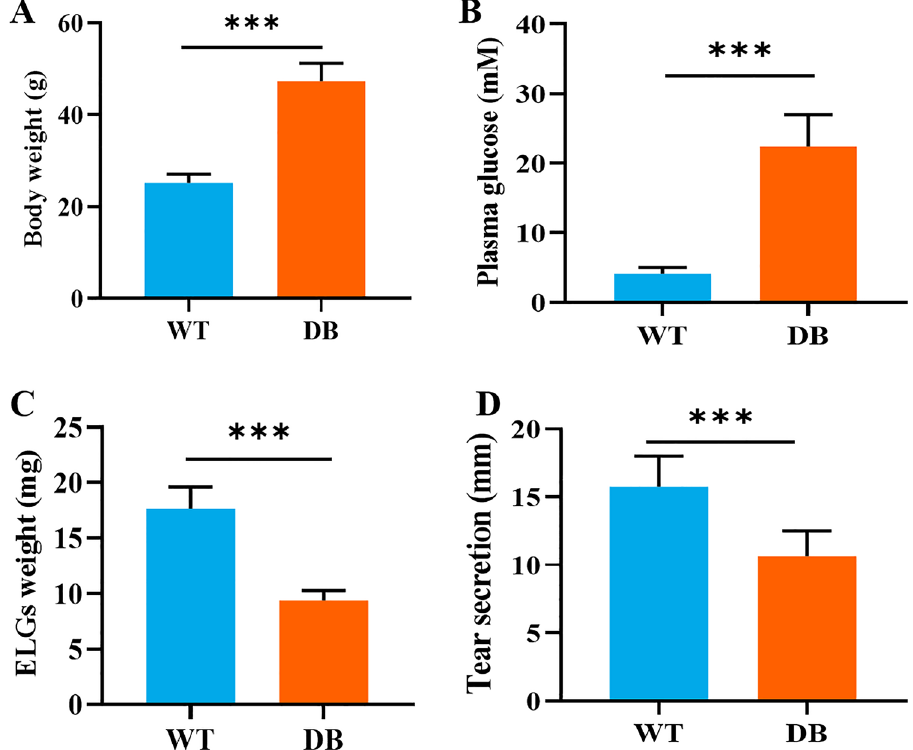
Figure 1. Comparison of general characteristics between WT and DB